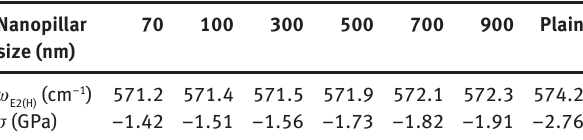
Table 1: Raman shifts for the E pressive stress σ of different nanopillar